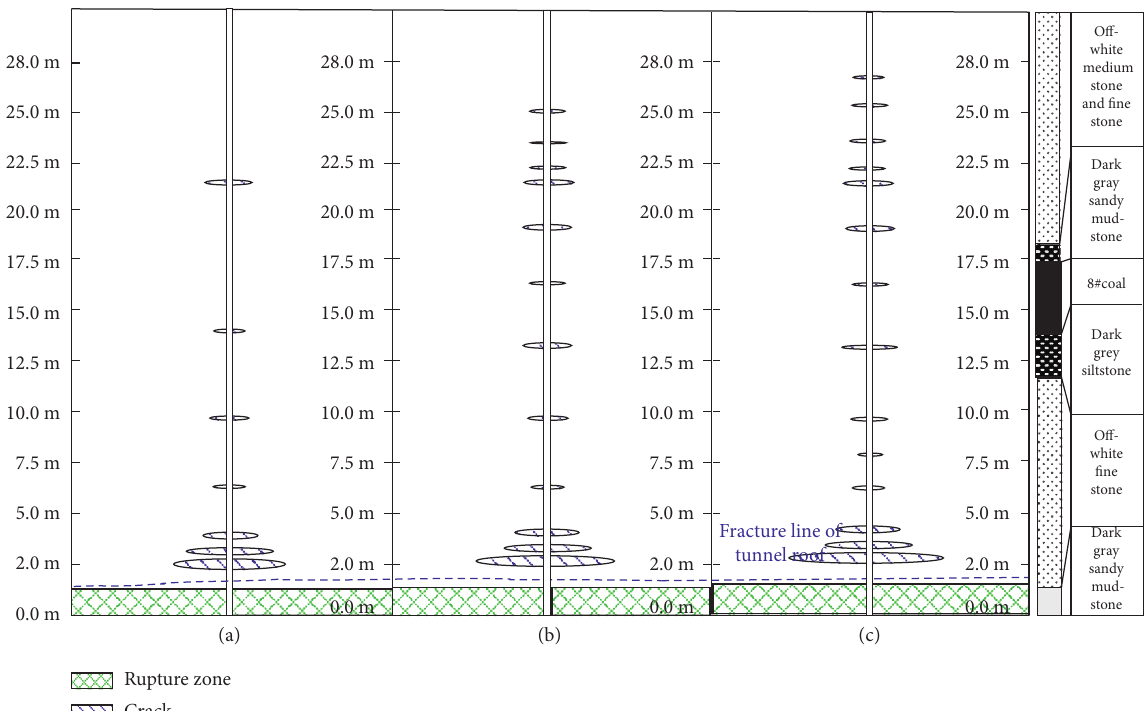
Figure 16: Fracture evolution of overburden strata with advancement of mining